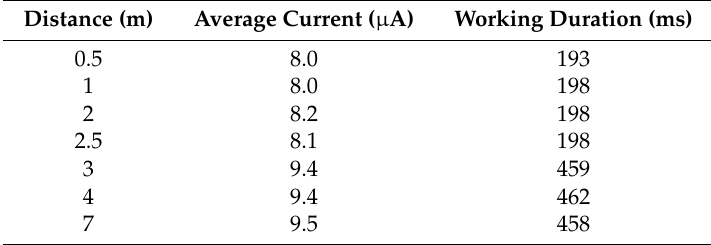
Table 1. The relation of distance between receiver and transmitter, the current of the receiver, and the working duration of the